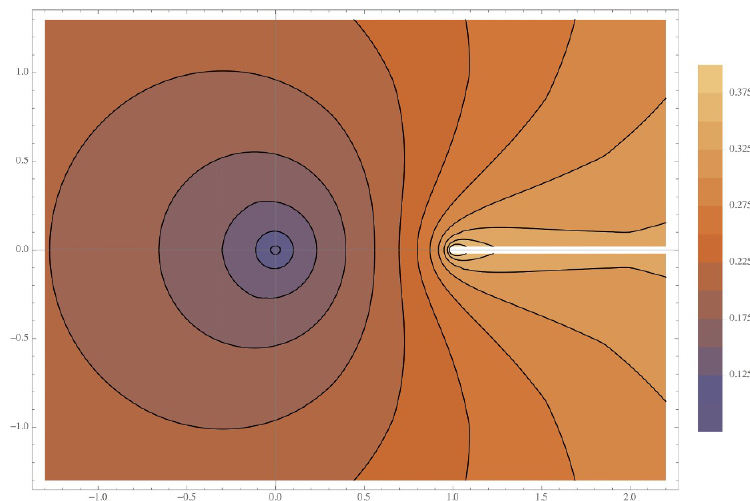
Figure 6. The Hausdor(cid:11) dimension of the Z symmetric genus two handlebody, as a function of 3 the (complex) cross-ratio x . Note that the Hausdor(cid:11) dimension goes to zero at the origin ( x = 0) and approaches one as x ! 1 along the real (cid:0)